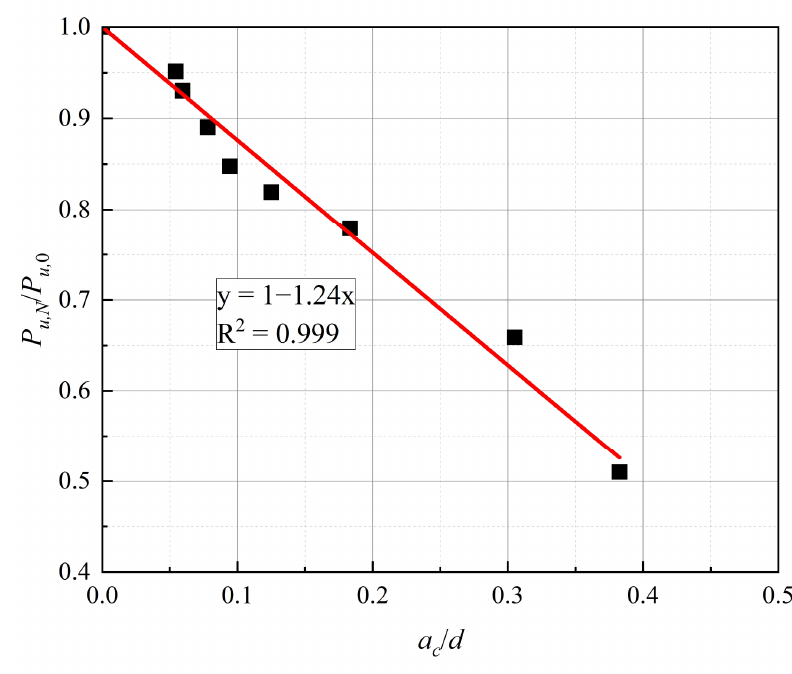
13 of 23 Figure 12. Load-slip curves of specimens under different cyclic loads. 3.3. Calculation Model for the Residual Bearing Capacity of Stud Shear Connectors To circumvent the difficulty in measuring the fatigue extension area of studs in struc- ture, the relationship between the ratio of the residual bearing capacity P u,N to the shear bearing capacity P u, 0 , and the ratio of fatigue crack depth to stud section diameter, is ob- tained through linear regression; this is to assess the residual bearing capacity of studs, in terms of the fatigue crack depth. The relationship between P u,N /P u, 0 and a c /d is shown in Figure 13. The slope of the